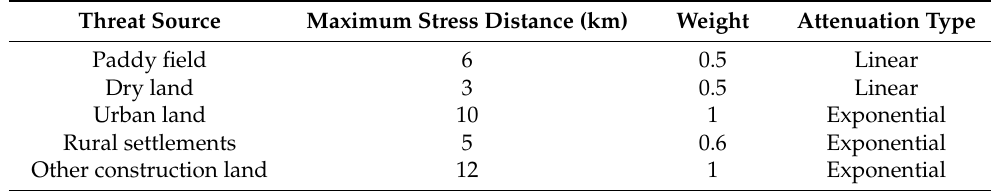
Table 5. The maximum impact distance, weight, and attenuation type of threat